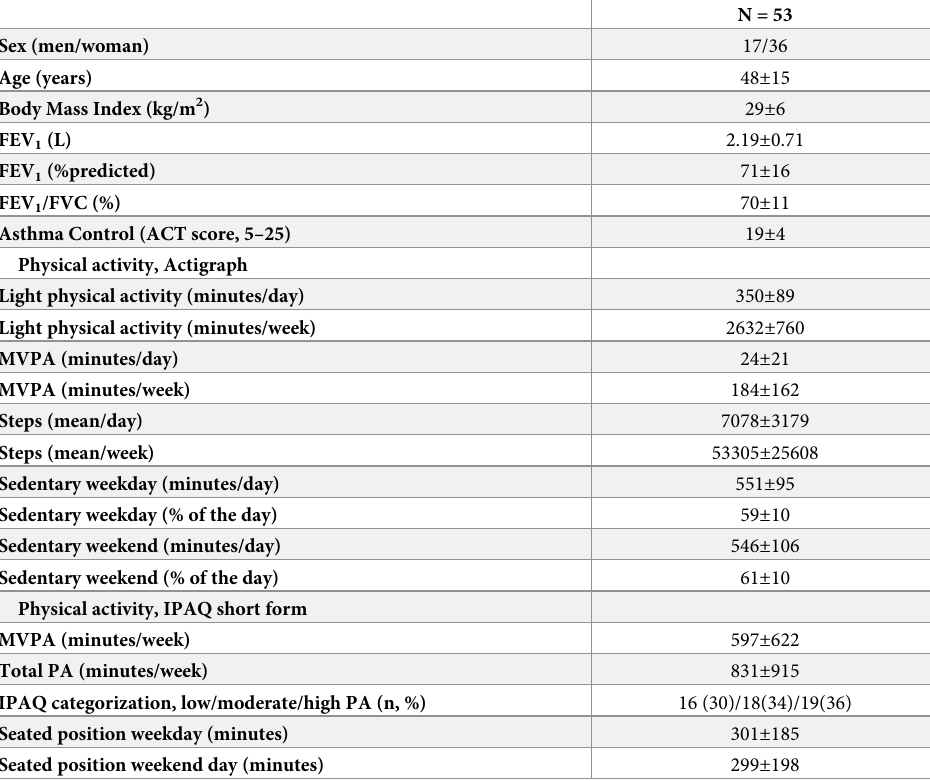
Table 1. Characteristics of the sample and results of physical activity assessed by both instruments (Actigraph and IPAQ-short form).